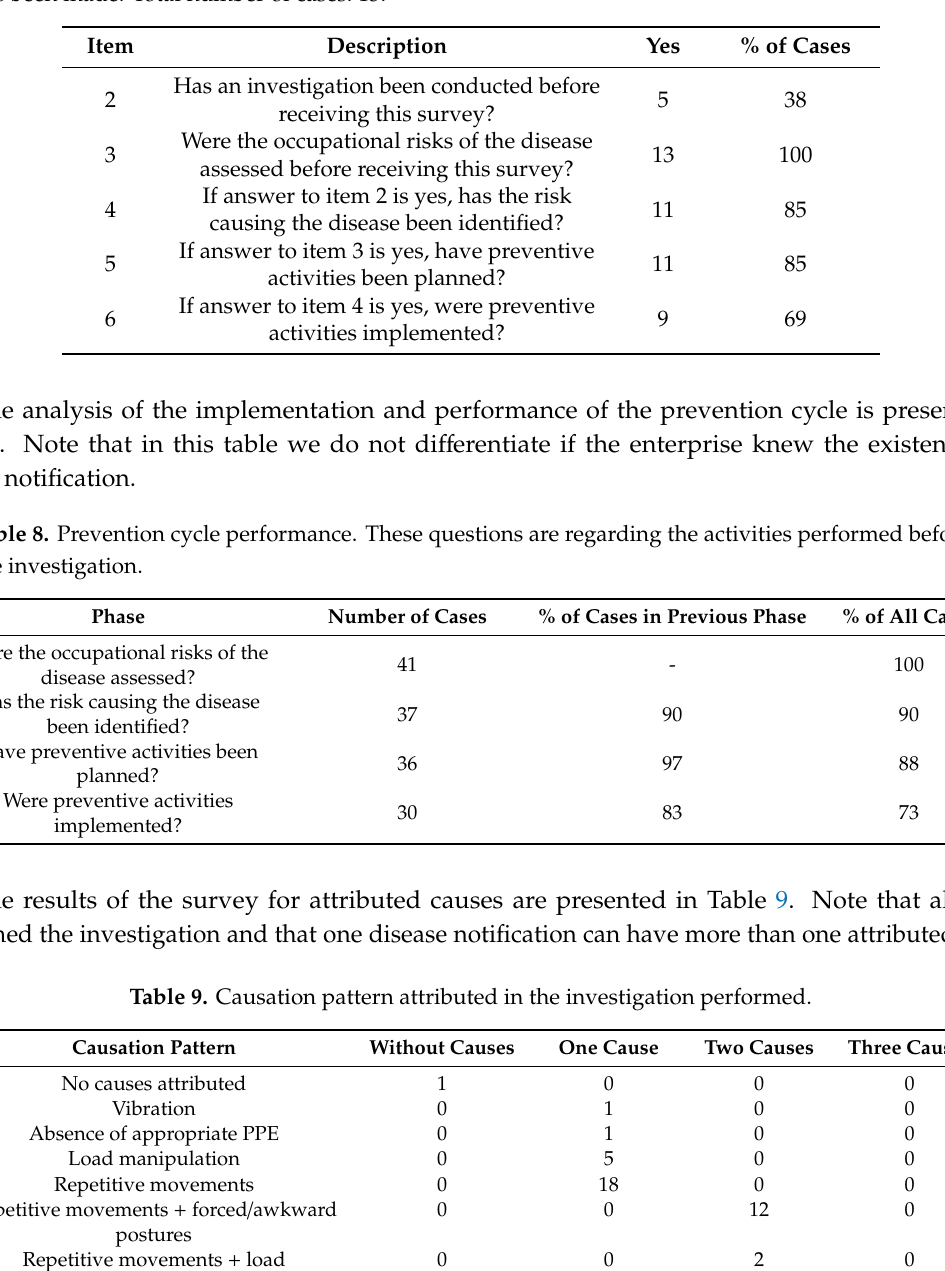
Table 7. Analysis of dichotomic answers when the enterprise did not know that the disease notification has been made. Total number of cases: 13.